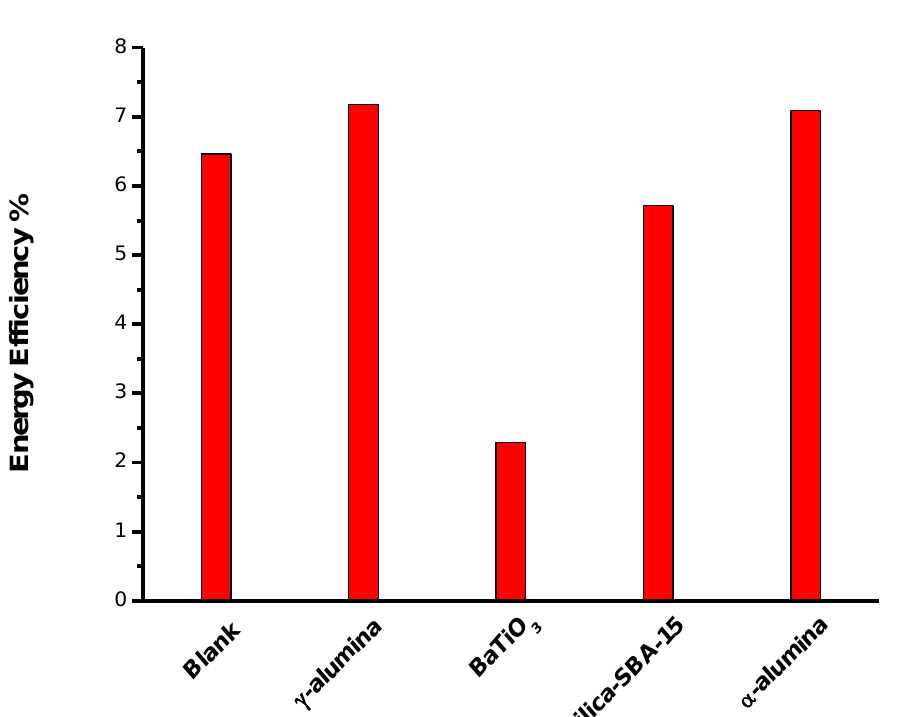
Figure 15. The energy efficiency for the blank (nonpacked) reactor and the packed reactor. The dielectric constants of α -alumina and γ -alumina are nearly the same. The conversion